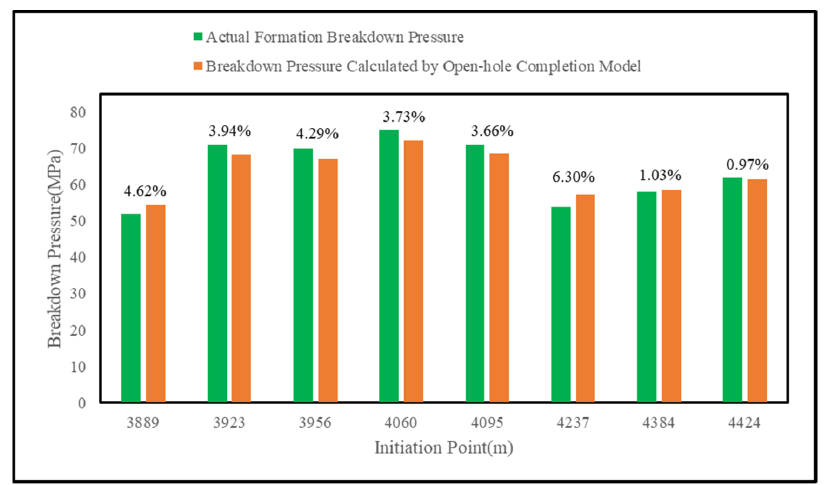
Figure 5. Comparison between the field construction breakdown pressure of open hole completion